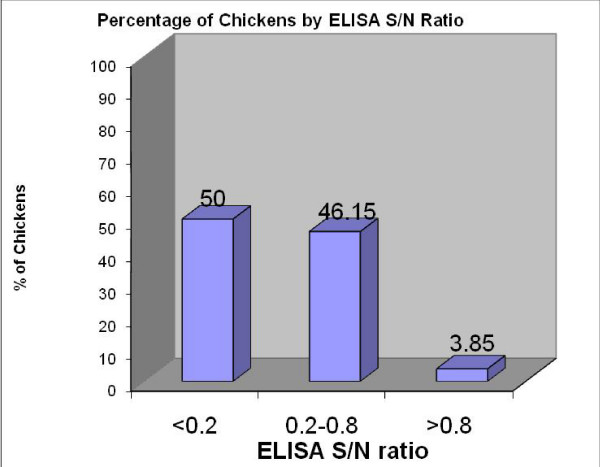
ELISA results of serum collected from commercial broiler breeder chickens. Fifty percent of the chickens have ELISA S/N < 0.2 which indicates the presence of high protective titers and able to afford high level protection to the progeny, meanwhile 46.15% of the chickens have ELISA S/N in the range of 0.2 to 0.8 affording low levels of protection to the progeny. Only 3.85% of the chickens have ELISA S/N > 0.8 indicating negative result for antibody against CAV.